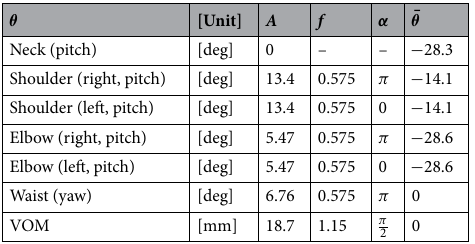
Table 1. The calculated parameters of each joint θ , the amplitude A , frequency f , phase difference α , and ¯ θ baseline for the gait-induced upper body